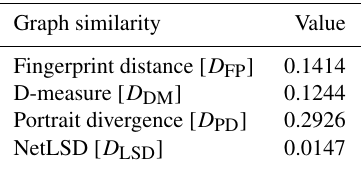
Table 3. Summary of graph similarities computed for example frac- ture